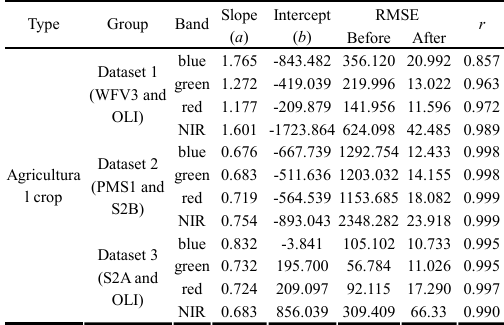
Table 6. Quantitative validation of agricultural crop study area